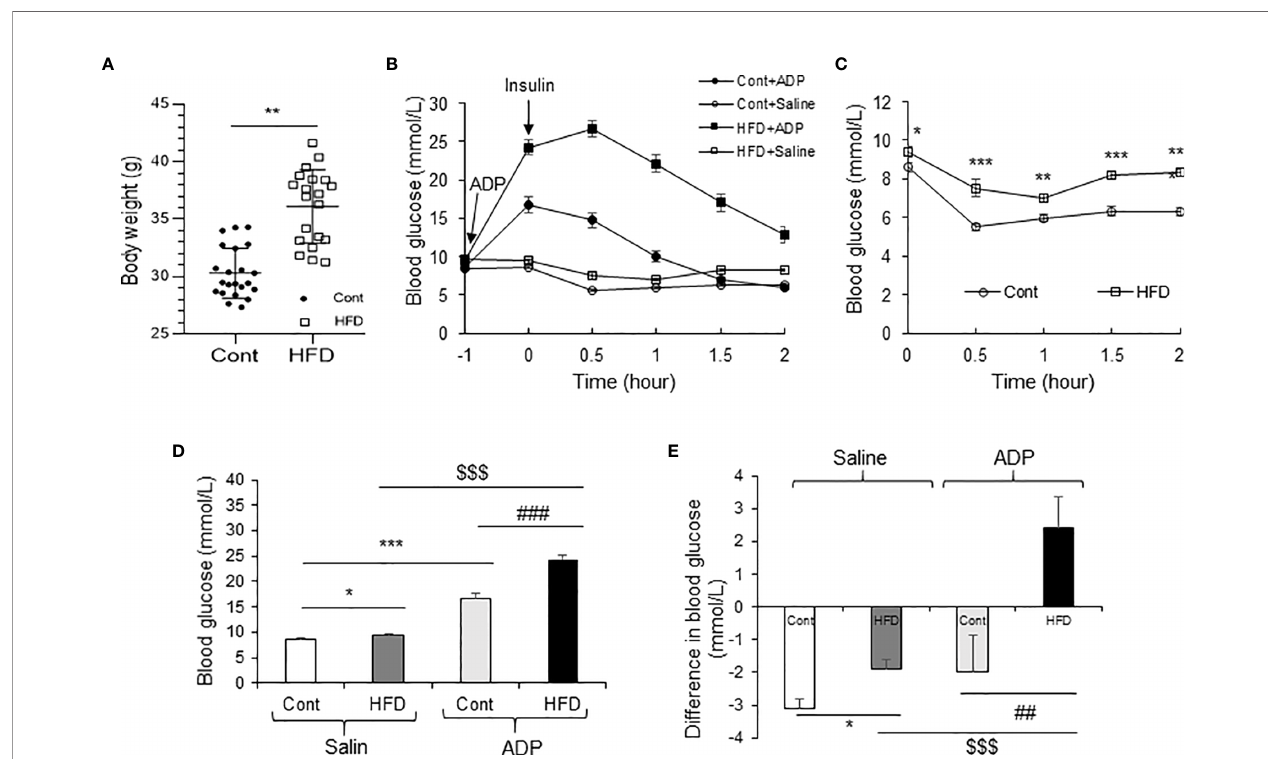
FIGURE 6 | ADP impaired insulin sensitivity in the DIO mice. (A) Body weight of Chow diet mice and high-fat diet mice (19-week-old, n=20). (B) Insulin tolerance test (ITT) after ADP injection. Normal mice and DIO mice were injected with ADP (125 mg/kg) or saline 1 hour before i.p. injecting insulin (1 U/kg). (C) ITT of normal mice and DIO mice without ADP. The data was derived from panel A. (D) Blood glucose after ADP injection at 0.5 h from panel A. (E) Blood glucose before and after insulin (1 U/kg) injection at 0.5 h. The data in this fi gure represent mean ± SEM (n=10). *p < 0.05; **p < 0.01; ***p < 0.001 vs. control group; ## p < 0.01; ### P < 0.001 vs. the ADP control group; $$$ P < 0.001 vs. the normal HFD